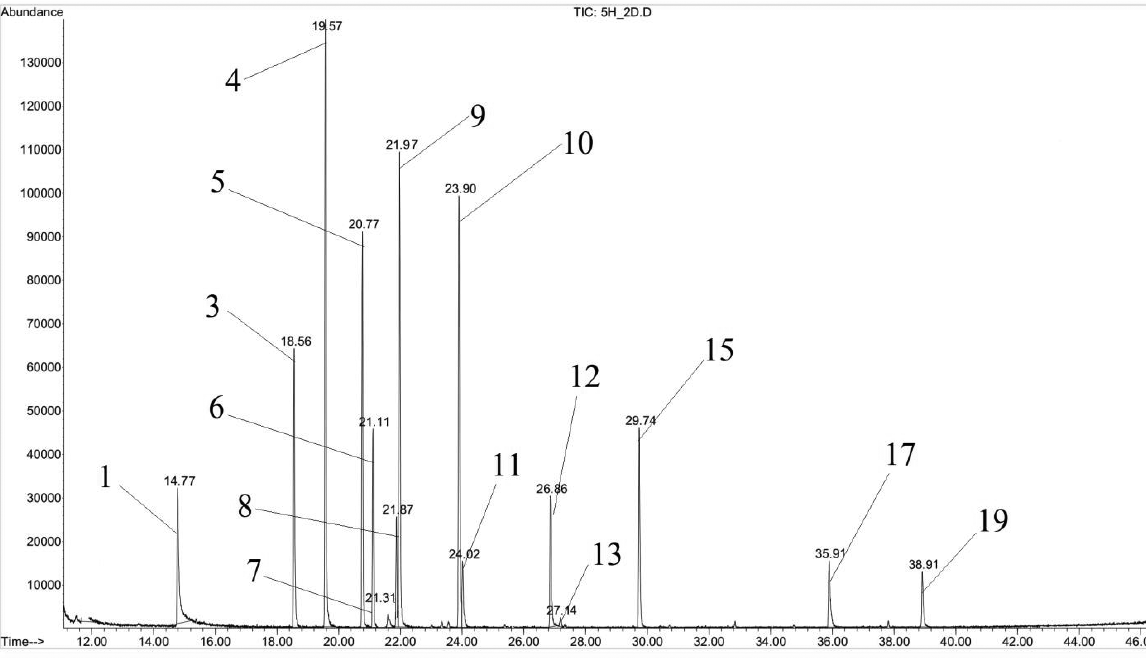
Figure 2. GC-MS chromatogram of amino acids after hydrolysis in the sample 1 of the plant